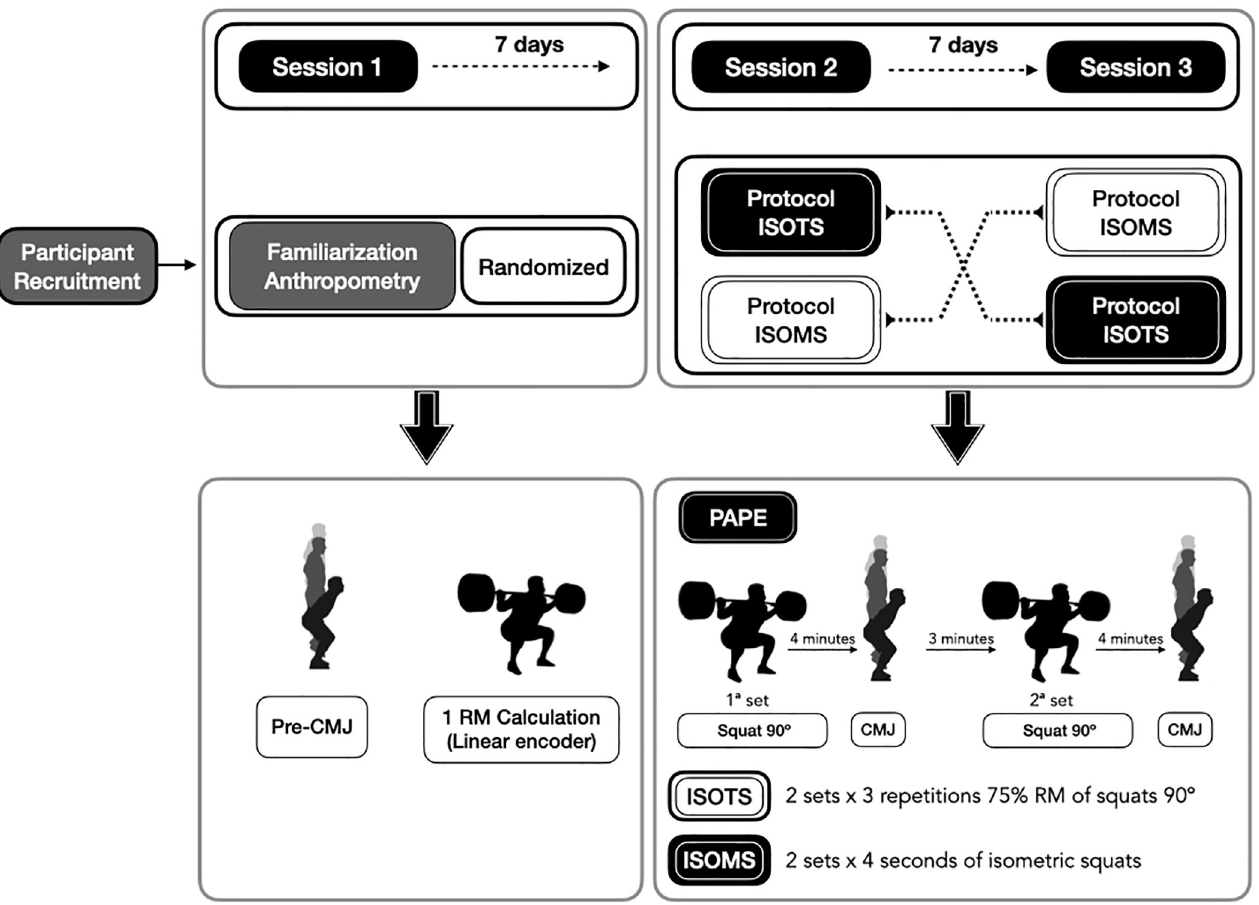
Fig 1. Schematic representation of the study